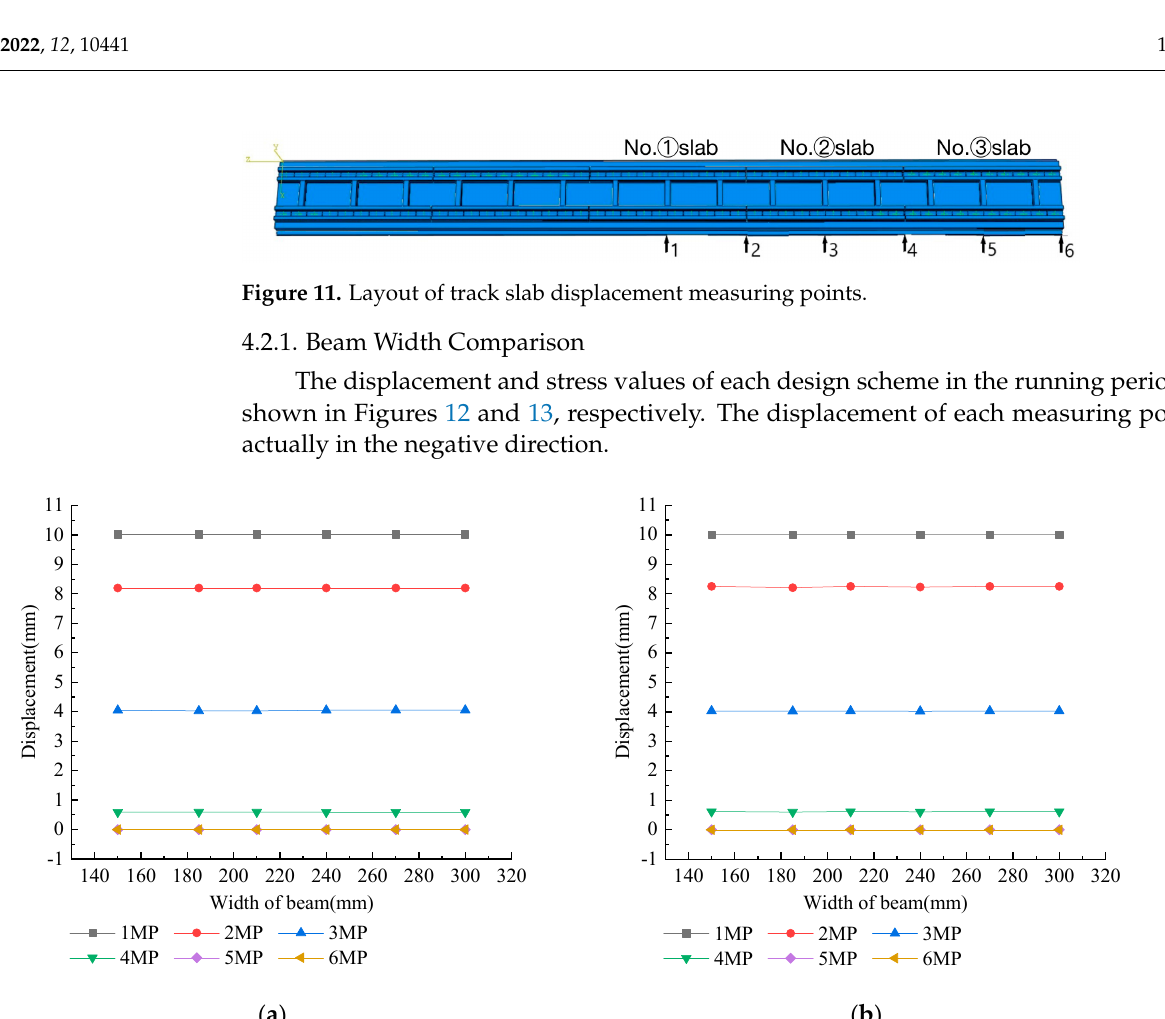
Figure 12. The vertical displacement trend of the rail seats and the bottom of the cast-in-place con- crete under the conditions of different beam widths during the running period. ( a ) Rail seats and ( b ) cast-in-place concrete.